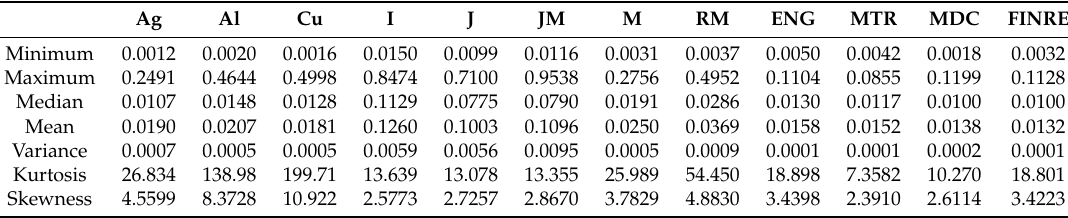
Table 3. Summary statistics of RTV for each